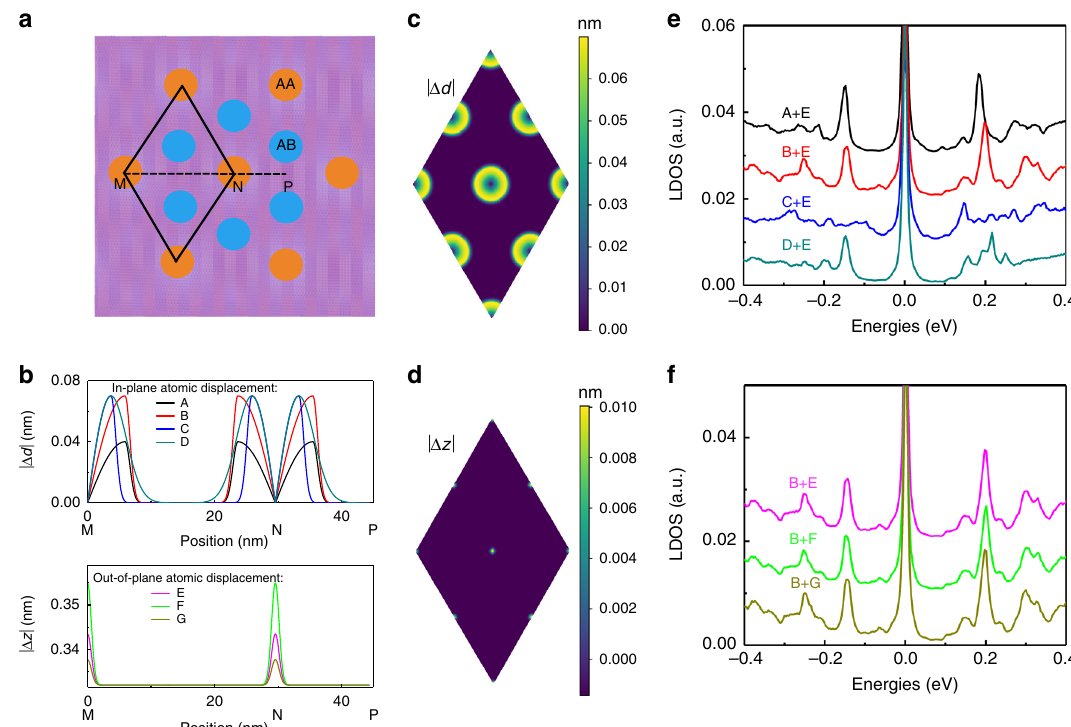
Fig. 3 Calculated results of the distorted TBG structure with θ ¼ 0 : 48 (cid:1) . a Schematic model of the moiré pattern. b Absolute magnitude of different in- plane atomic displacements (top panel) and out-of-plane displacements for the deformed system along the path MNP de fi ned in a . For the in-plane displacements, the parameters ( Δ D , l D , σ D ) are: A (0.04 nm, 5.91 nm, 1.14), B (0.07 nm, 5.91 nm, 1.14), C (0.07 nm, 3.70 nm, 1.14), D (0.07 nm, 3.70 nm, 11.44). For the out-of-plane displacements, the parameters ( Δ Z , l Z , σ Z ) are: E (0.0115 nm, 4.93 nm, 0.7), F (0.023nm, 4.93 nm, 0.7), G (0.0058 nm, 4.93 nm, 0.7). c , d Maps of the absolute magnitude of the in-plane atomic displacement j Δ d j and out-of-plane displacement Δ z upon deformation of rigidly TBG calculated from Eq. (1), respectively. e , f Local density of states in the AA region of deformed systems with different in-plane and out-of-plane displacements, rotation about the axis perpendicular to the AA point ( C 0 ). The 2 deformed sample maintains the D point group symmetry 36,37 . For 3